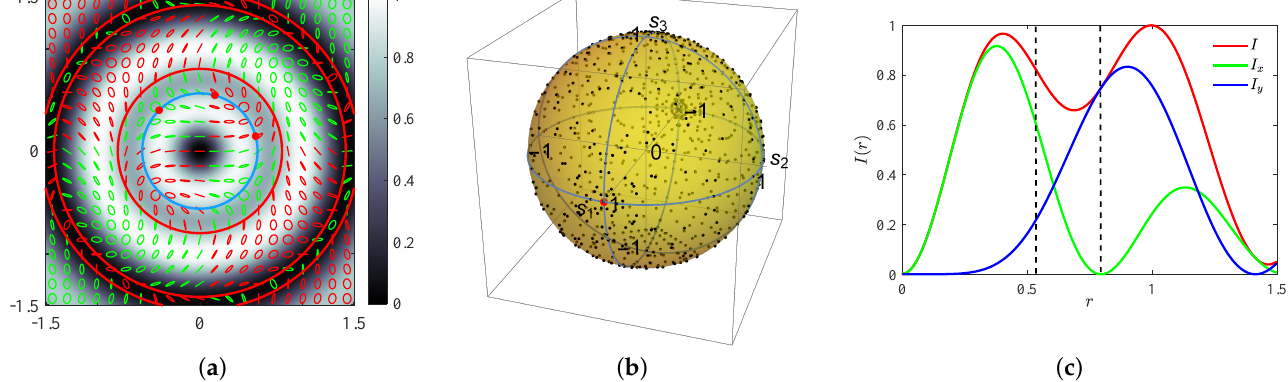
Figure 5. ( a ) Transverse intensity and polarization pattern for the field in Equation (22) where handedness is codified by the color of the ellipses (green = right, red = left, and red is also used for linear polarization), and distances are normalized to the beam spot size; ( b ) corresponding states of polarization represented by black dots on the Poincaré sphere, and the red dot indicates horizontal linearly polarized light; ( c ) intensity profile and contribution of each field component where the black dots represent distances, r , where the optimum polarization for polarimetric measurements can be